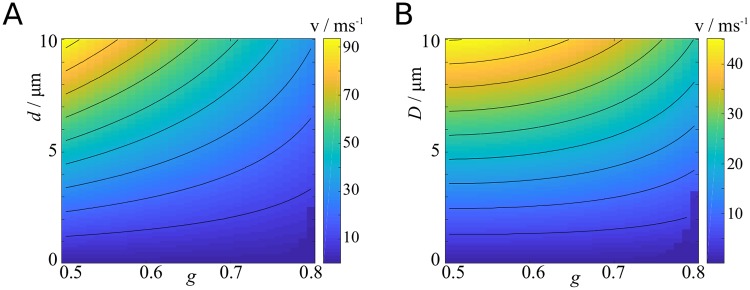
Effect of diameter and g-ratio on propagation velocity.A: Velocity plotted against g-ratio and axon diameter.B: Velocity plotted against g-ratio and fibre diameter.